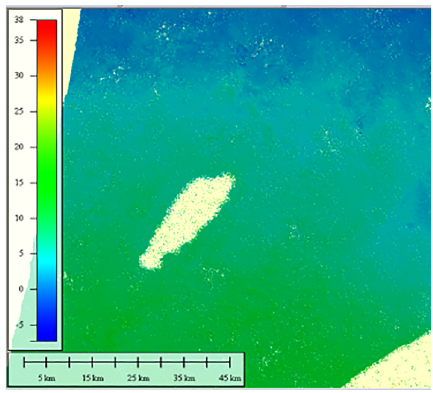
Figure 9. Phase unwrapping